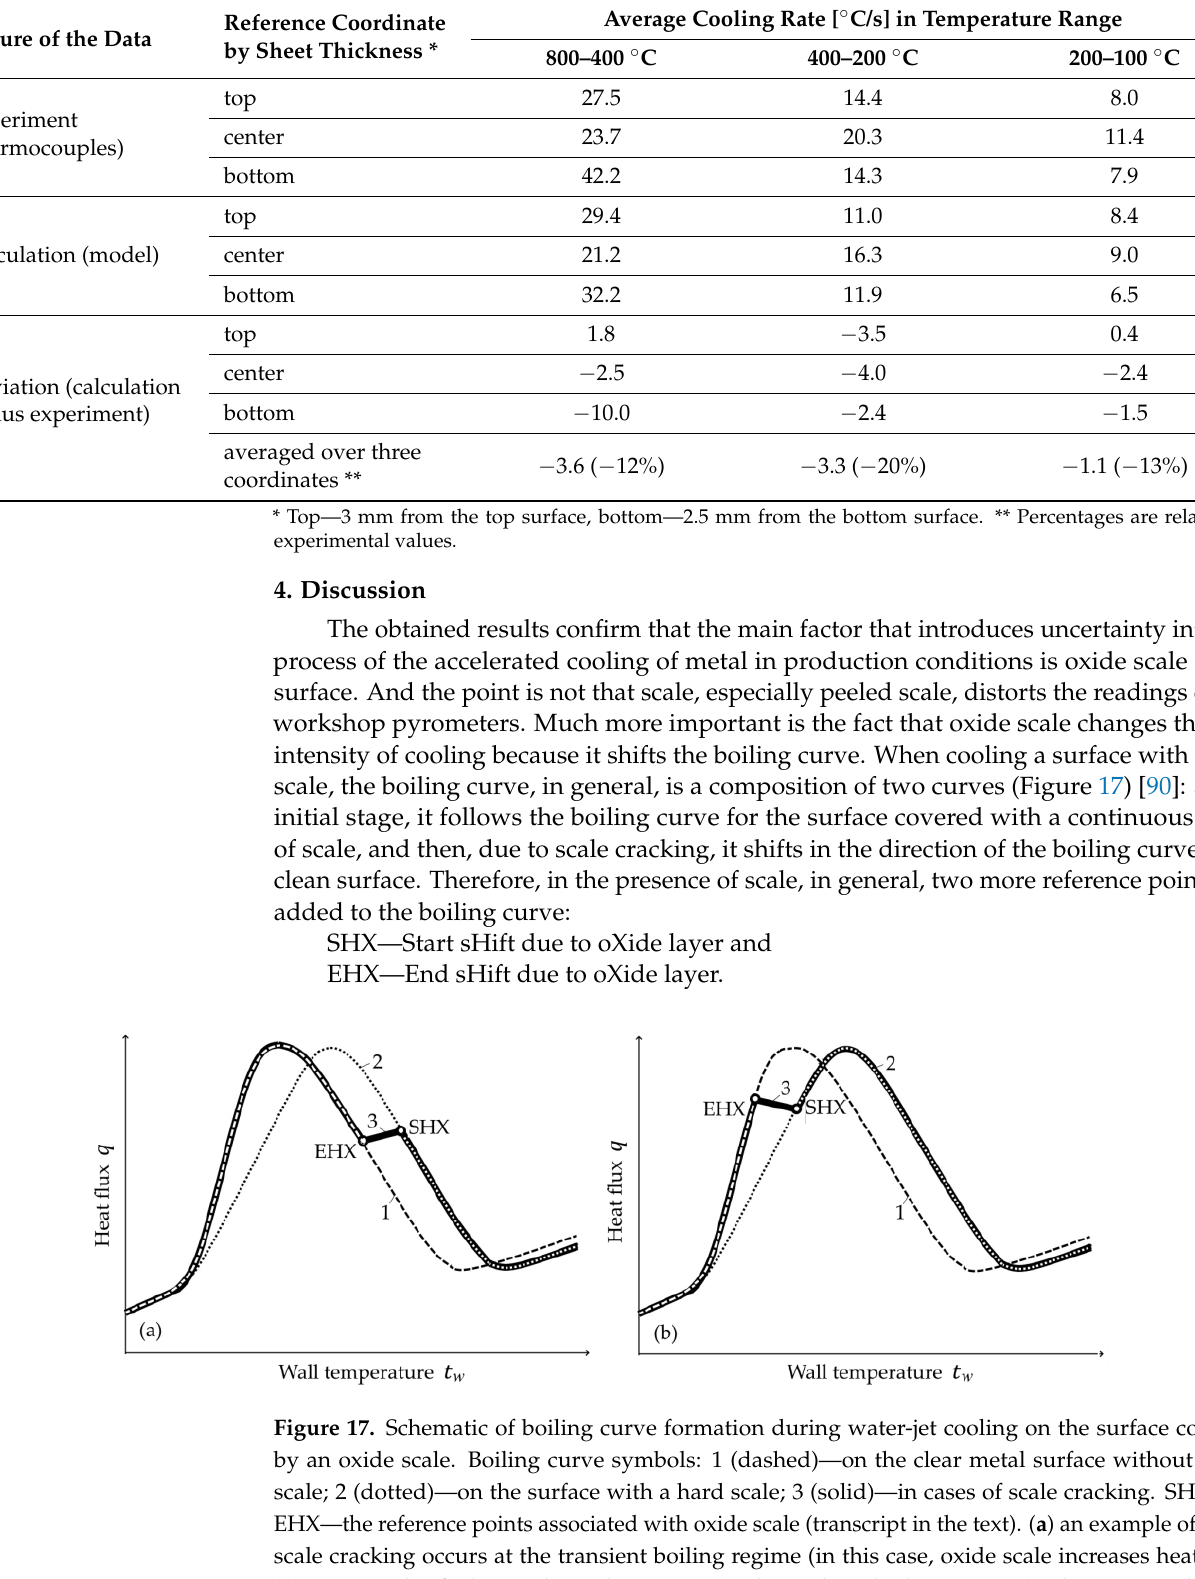
Table 3. Average cooling rate in characteristic temperature intervals.